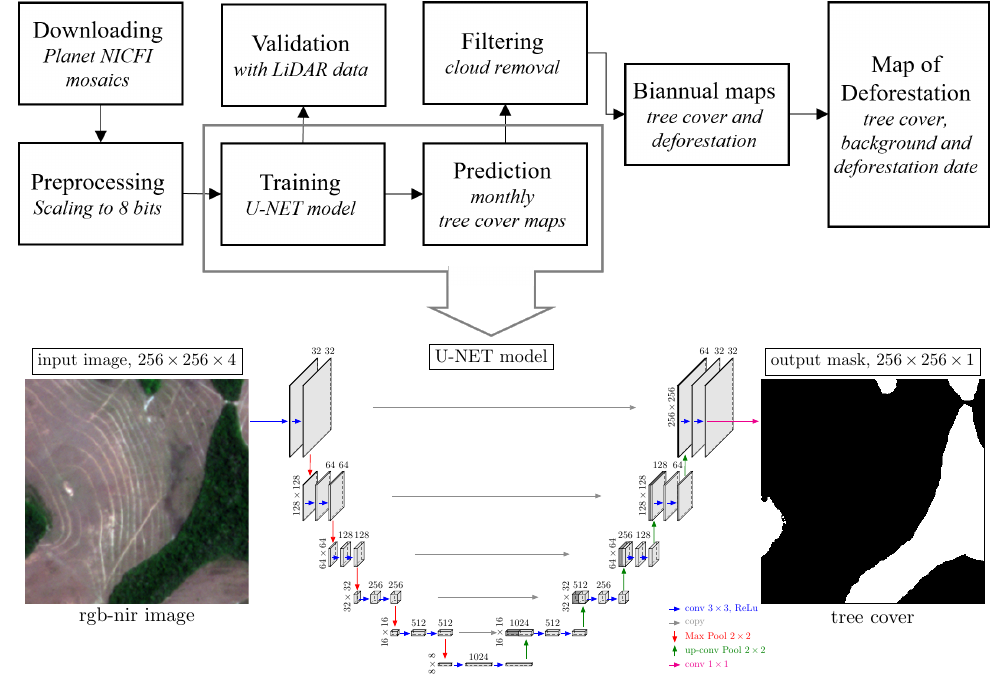
Figure 2. Overall flowchart of the deforestation mapping with planet NICFI and architecture of the U-net model used to produce tree cover